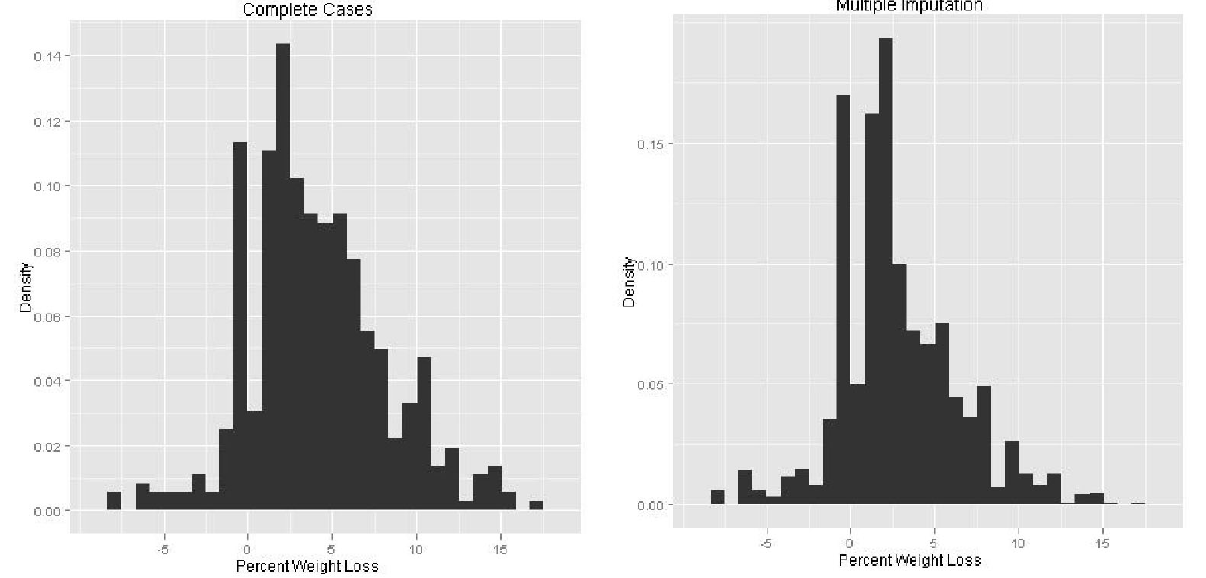
Table 5. Means, standard deviations, and P values for ratings of liking, difficulty to use, and helpfulness of the websites presented by website condition (labelled means without a common letter differ significantly according to Bonferonni-adjusted pairwise comparisons, P < .05).